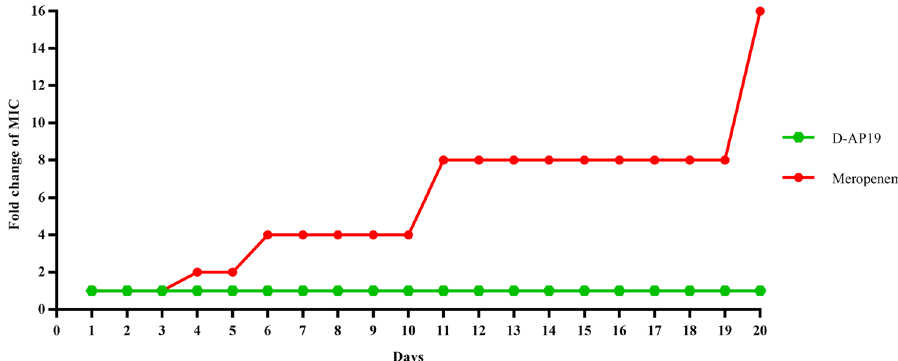
Figure 8. Fold changes of MICs of D-AP19 and meropenem against A. baumannii ATCC 19,606. The serial passages of bacteria were grown for 20 days in the presence of test compounds at different concentrations. The MIC and MBC values were determined after each